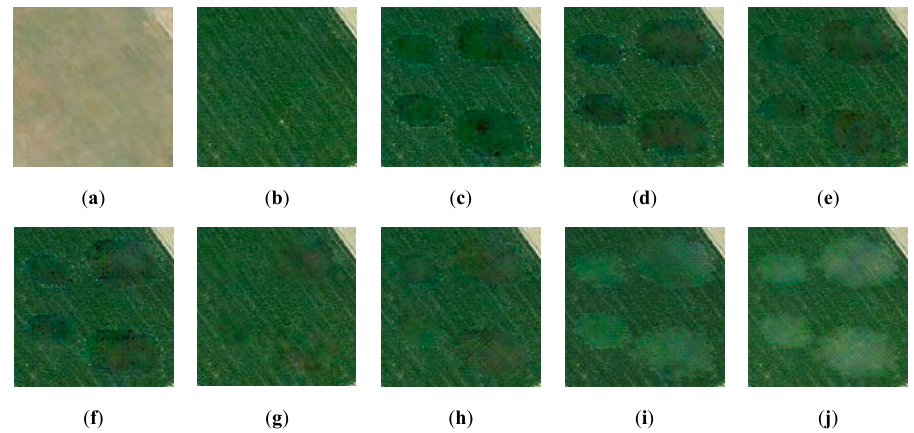
Figure 12. Results of the proposed model with different weight of perceptual loss. ( a ) Output of the simulation network when it fails to work; ( b ) ground truth; ( c ) λ 3 = 10 − 4 ; ( d ) λ 3 = 10 − 3 ; ( e ) λ 3 = 10 − 2 ; ( f ) λ 3 = 10 − 1 ; ( g ) λ 3 = 0.8; ( h ) λ 3 = 10; ( i ) λ 3 = 100 ( j ) λ 3 = 1000.